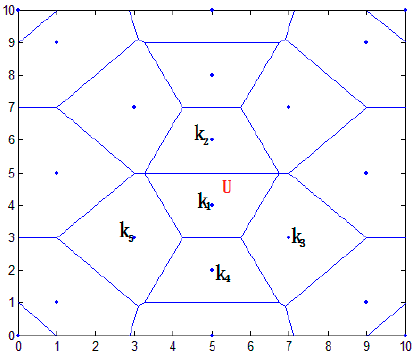
Figure 4. Overall positioning results. Figure 3. Overall positioning results.